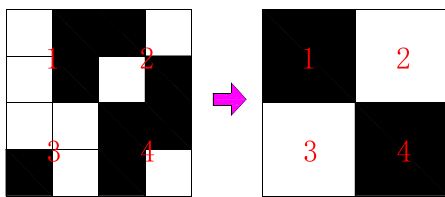
Figure 3. Rescaling process of the renormalization group method (schematic).